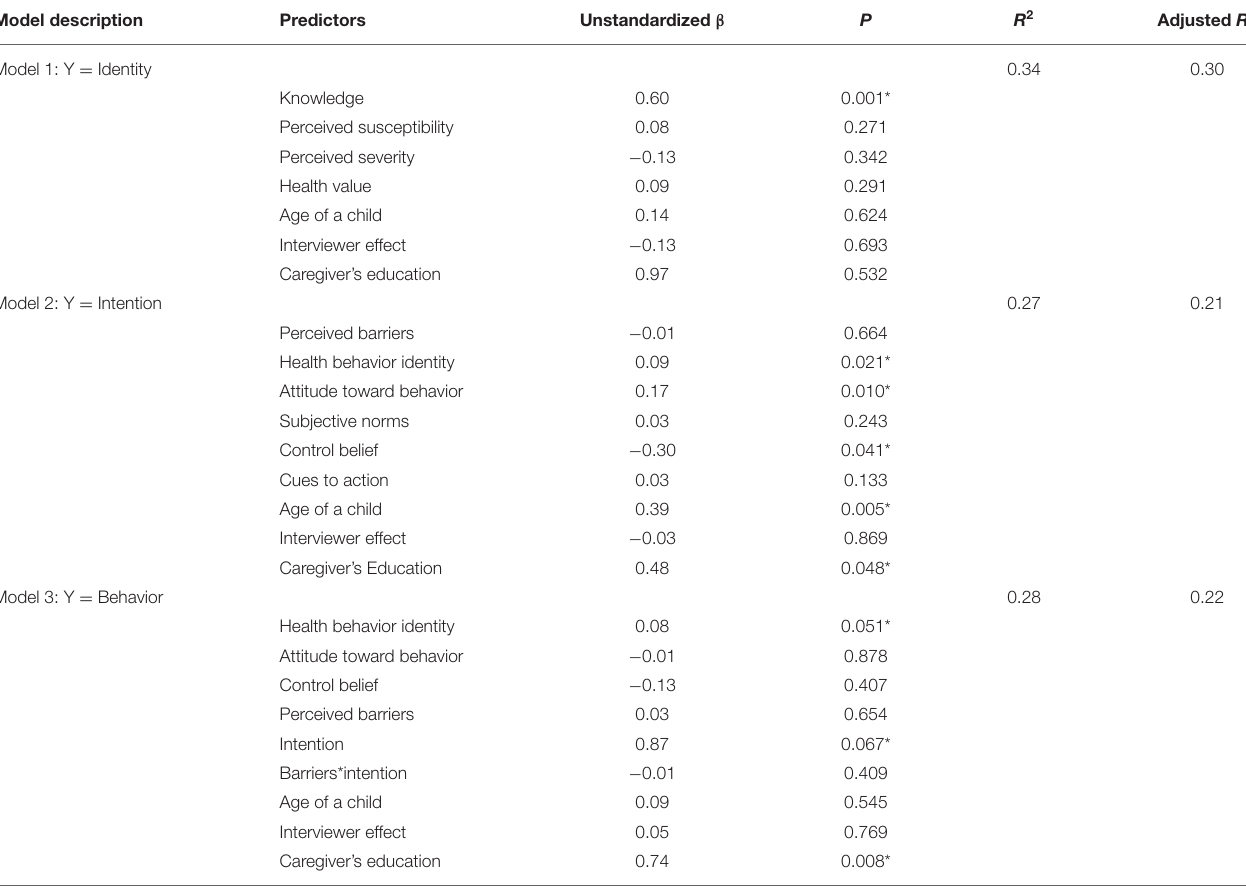
TABLE 6 | Constructs associated with health behavior identity, intention to feed pearl millet to children of school going age and feeding pearl millet to school aged children. Model